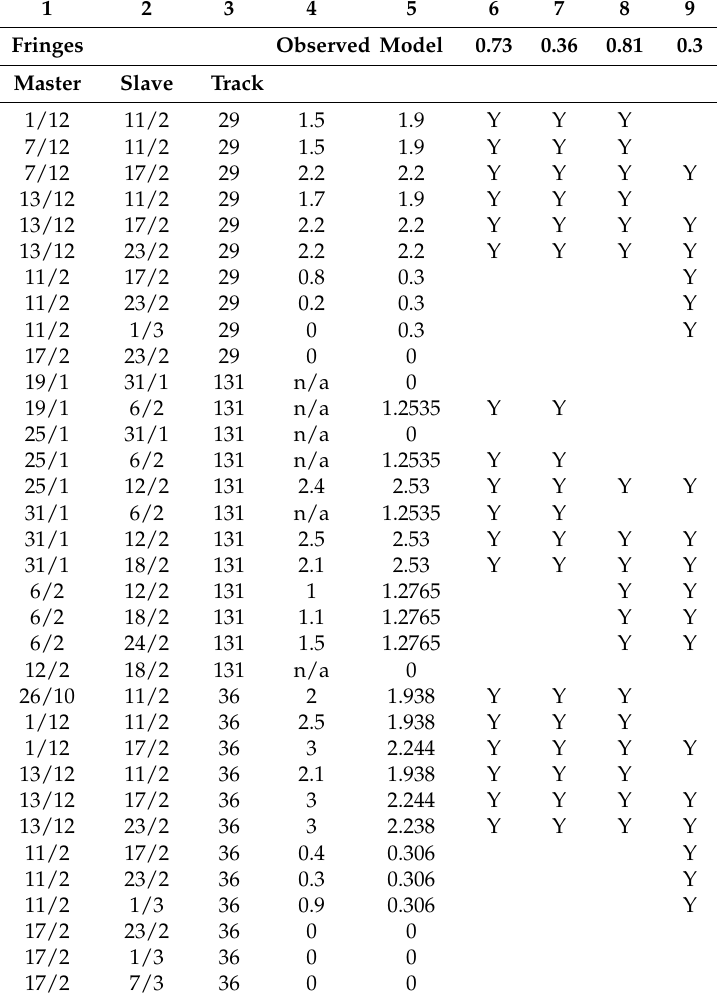
Table 4. List of forty-nine (49) interferograms of the Gulpinar-Babakale area produced by the COMET LiCSAR (http://comet.nerc.ac.uk/COMET-LiCS-portal/). First two columns: dates of the master and slave image. Third column: track. Fourth column: number of fringes measured on the interferograms. Fifth column: best fitting value that minimizes the scatter with the observations, obtained by summing the contributions of each earthquake captured by the interferogram (indicated by a Y in columns 6 to 9; the numbers in column 5 indicate the best fitting deformation, in number of fringes along the line of sight) in the minimization.